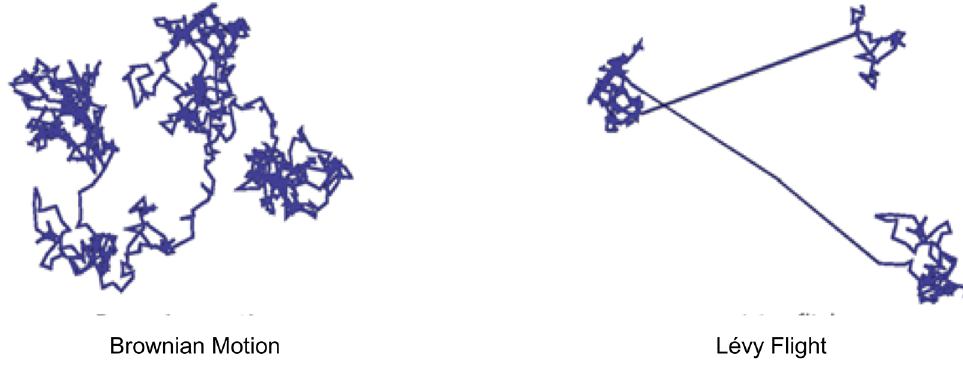
Fig 4. Brownian motion versus le´vy flight motion adopted from [39].